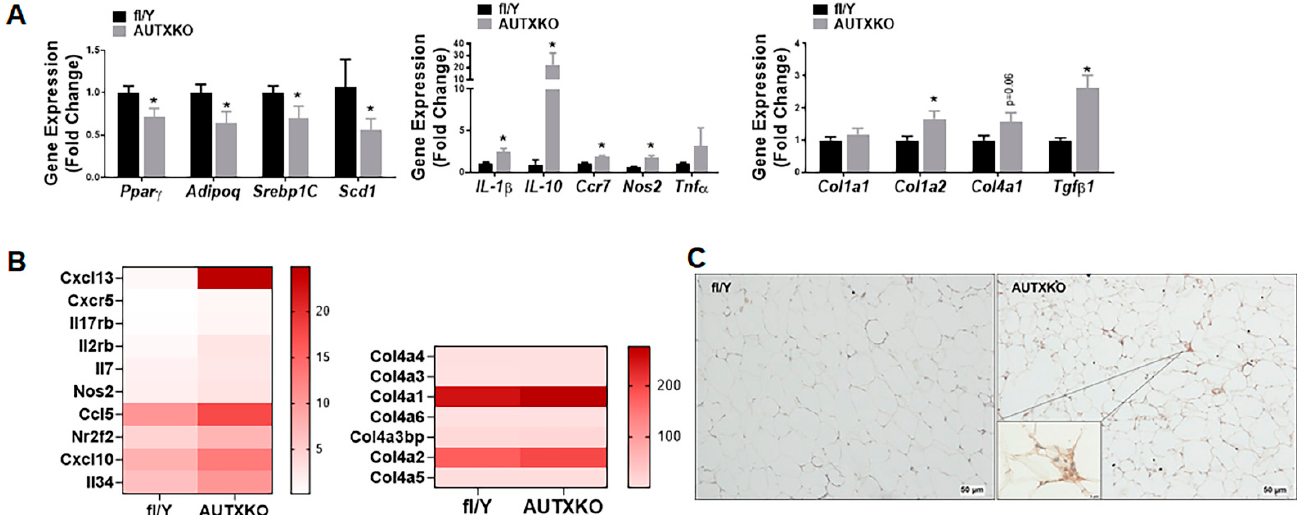
Figure 7. Utx deficiency in adipocytes causes metabolic dysfunction in adipose tissue. Five-week-old male AUTXKO and fl/Y animals were challenged with an HFD. ( A ) RT-PCR measurements of genes encoding lipogenesis, inflammation and fibrosis in WAT. All data are presented as mean ± SEM; n = 7–11/group; * p < 0.05 vs. fl/Y . ( B ) RNA-seq analysis reveals an up-regulation of pathways underlying inflammation and fibrosis in the eWAT of AUTXKO mice. ( C ) Immunohistochemical staining of macrophages with an anti-CD68 antibody in the white adipose tissue.